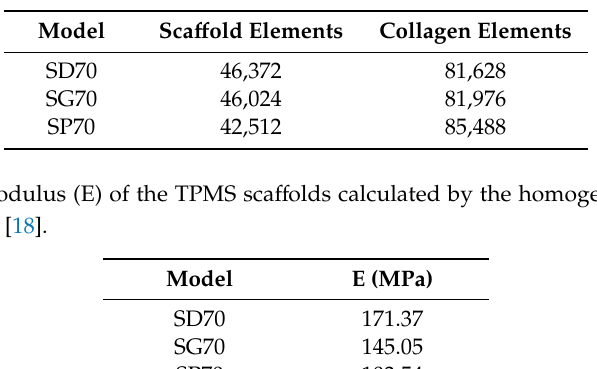
Figure 3. Finite element (FE) models of triply periodic minimal surface (TPMS) sca ff olds embedded in 0.20% collagen substrate (left: SD70; center: SG70; right: SP70). Please note that dark green represents the sca ff old and light green the collagen substrate. Table 1. Number of elements per material.